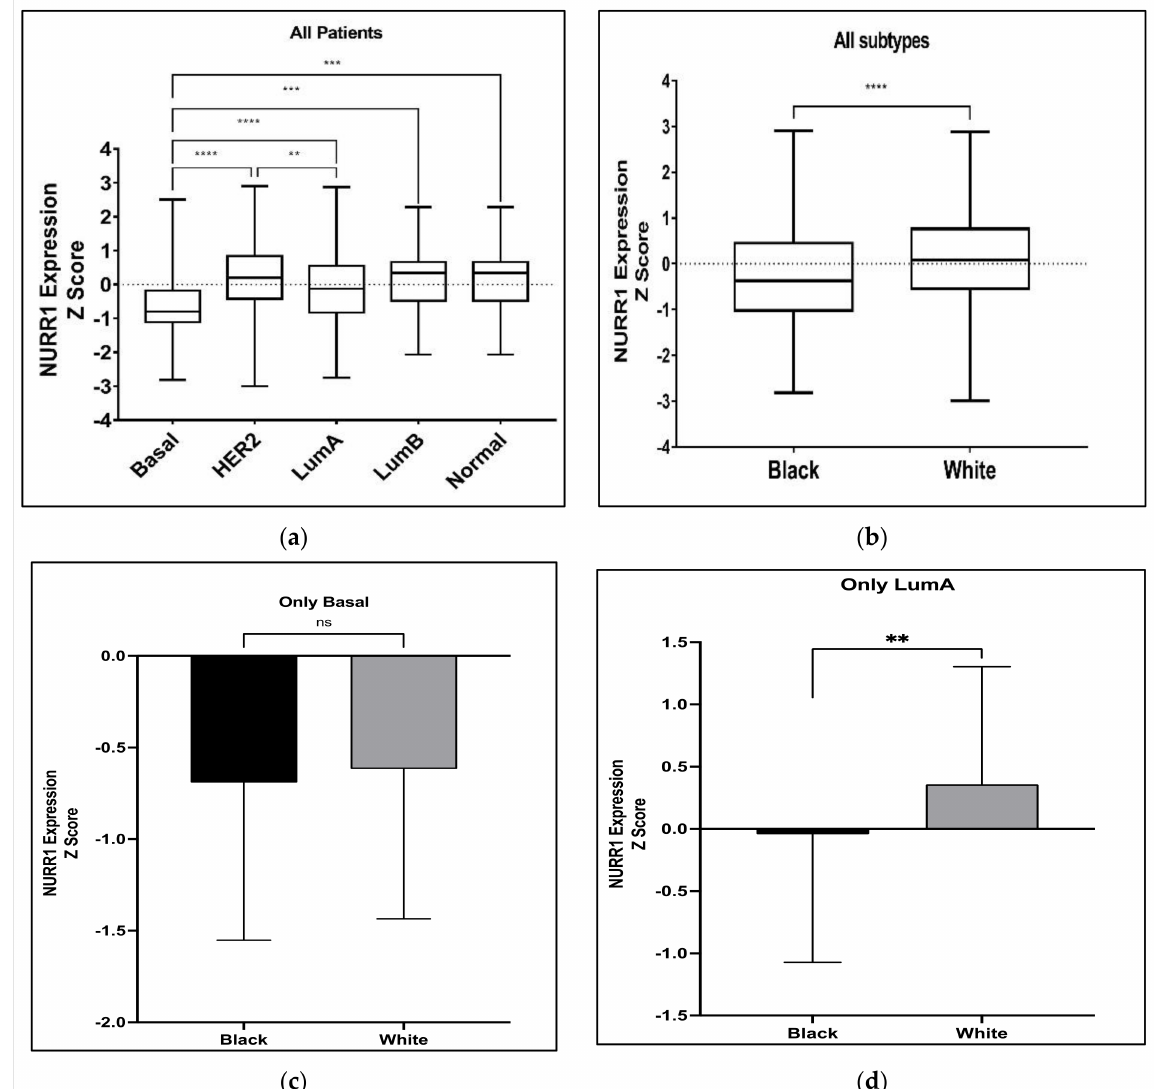
Figure 2. Expression levels of NURR1 in different BCa subtypes among Black and White BCa women. Overall expression of NURR1 ( a ) was found to be higher in LumA subtype and low in Basal-like cancer subtype in all BCa women; ( b ) was found to be low in Black BCa women than in other groups; ( c ) in Basal-like cancer subtype was found to be low in both Black and White groups; ( d ) was low especially in Black women with LumA subtype BCa. **** ( p < 0.0001), *** ( p = 0.0034), ** ( p = 0.0189), ns: not